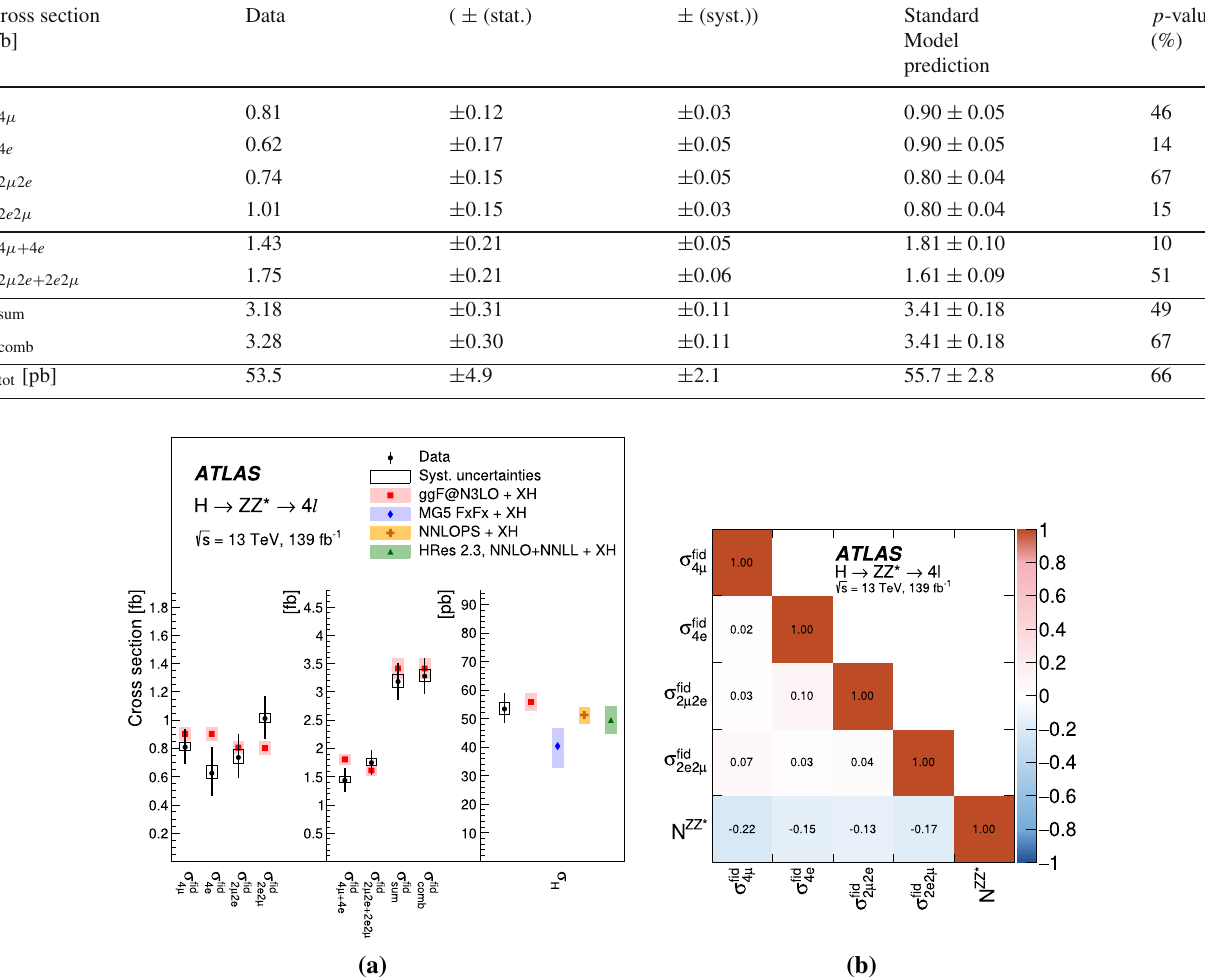
acceptances determined using the NNLOPS sample for ggF and the samples discussed in Sect. 3 for the other production modes. For the total cross section, the predictions by the generators NNLOPS , Hres , and MadGraph5_aMC@NLO -FxFx are also shown. The error bars on the data points show the total uncertainties, while the systematic uncertainties are indicated by the boxes. The shaded bands around the theoretical predictions indicate the PDF and scale uncertainties, calcu- lated as described in Sect. 8.2. b The correlation between the